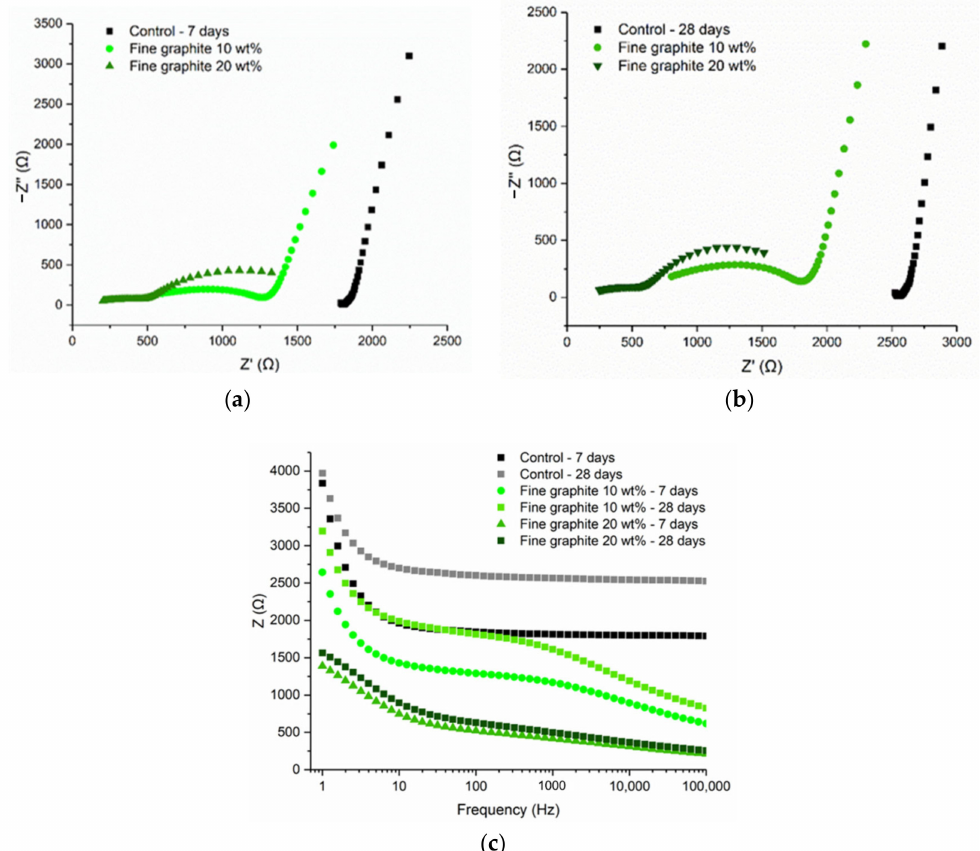
Figure 13. Cement paste with fine graphite: ( a ) 7-day Nyquist plot, ( b ) 28-day Nyquist plot, and ( c ) frequency-dependent